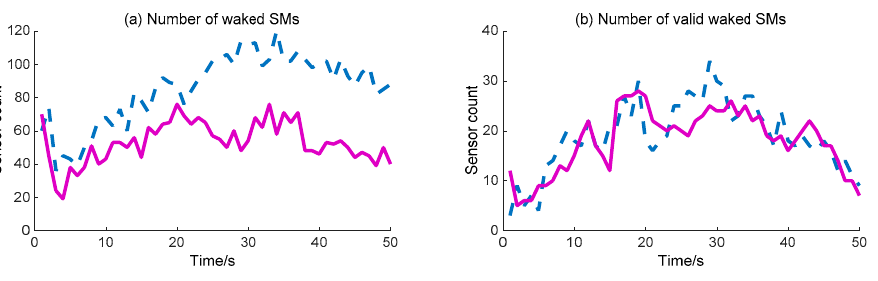
Figure 10. The state of the CM at the 30th time interval.